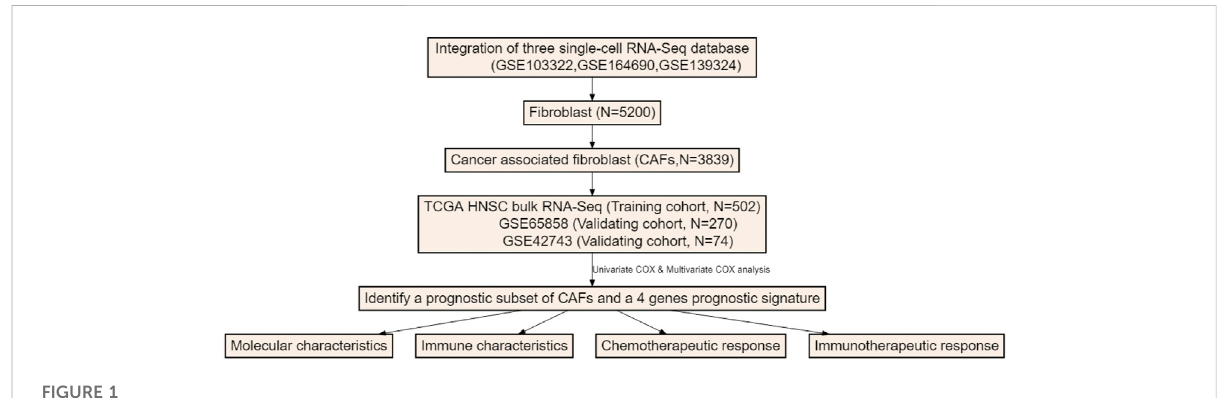
FIGURE 1 The fl ow chart of this